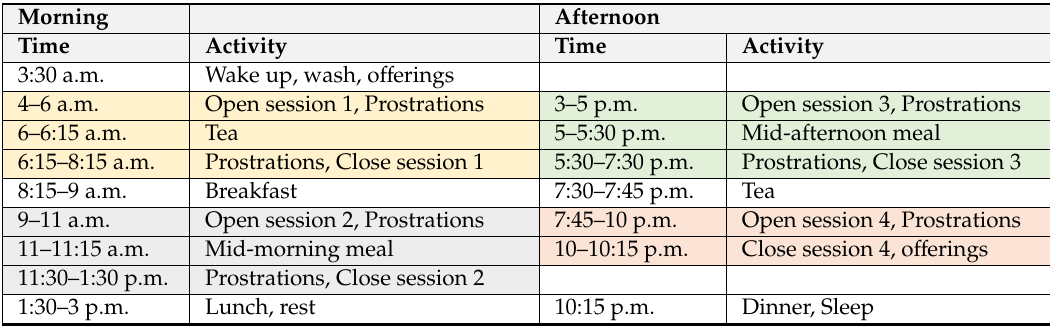
Table 1. Daily schedule of